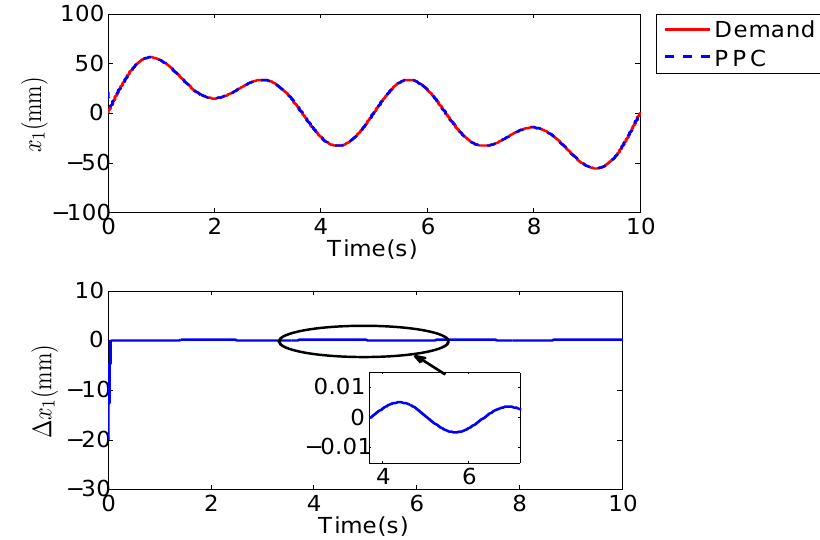
Figure 4. The cylinder position responses x 1 by prescribed performance constraint controller with ∆ ∆ 2 = 3 = 0, the demand y d = 25 ( sin ( 0.8 π t ) + sin ( 0.4 π t ) + sin ( 0.2 π t )) .